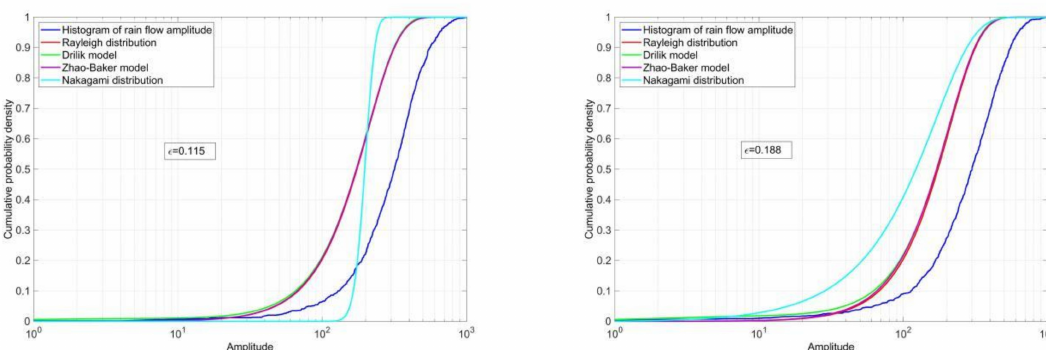
Figure A7. Probability density distribution of rain flow amplitude (band-limited white noise spectrum).